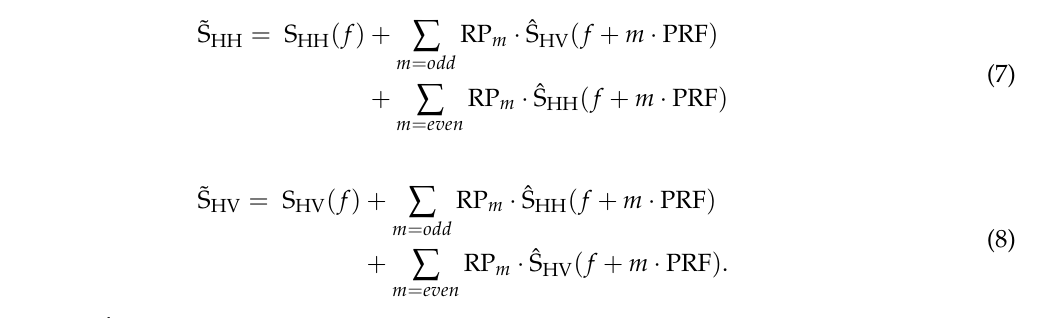
at last refocusing the desired